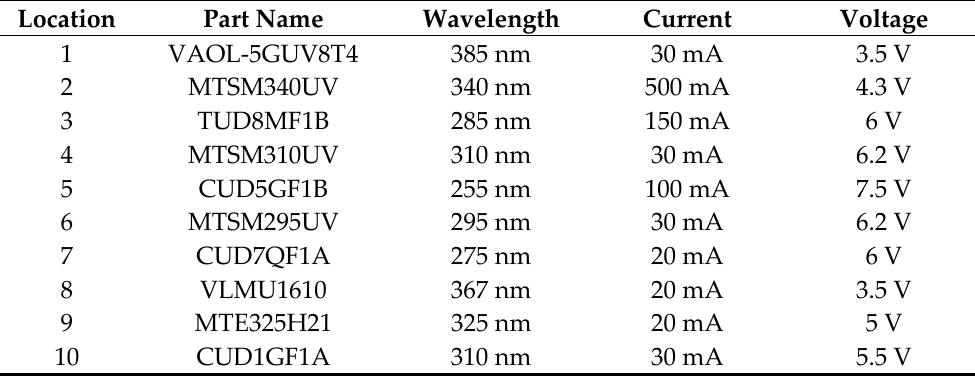
Table 4. The Parameters of 10